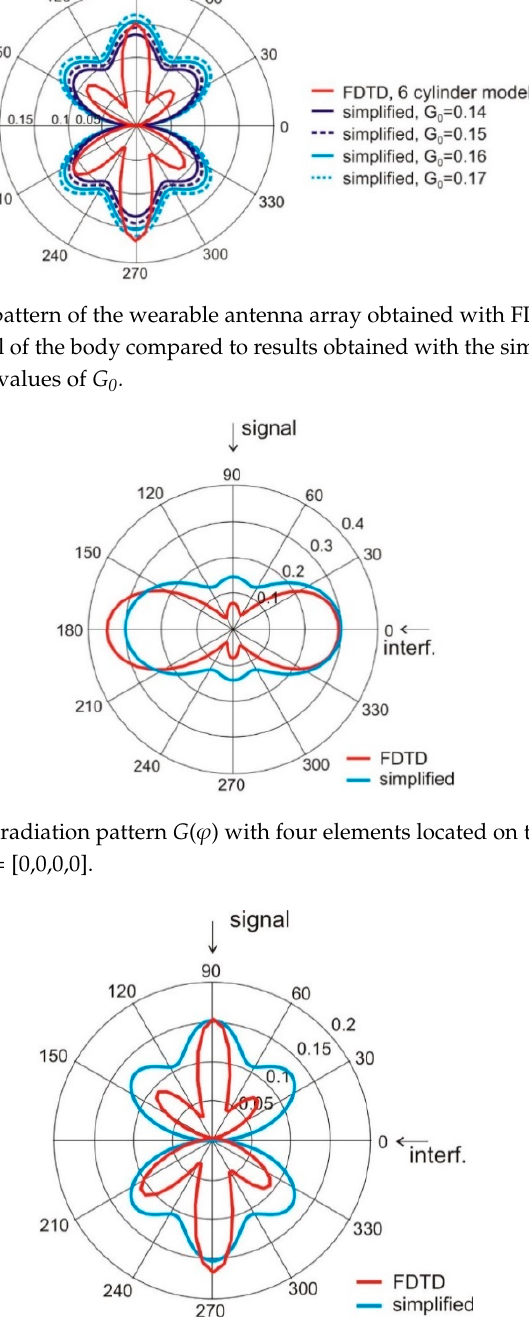
Figure 7. Antenna array radiation pattern G ( ϕ ) with four elements located on the ψ = [ − 20 ° , 20 ° , 160 ° , 200 ◦ ]; α = [0, π , π , 0].